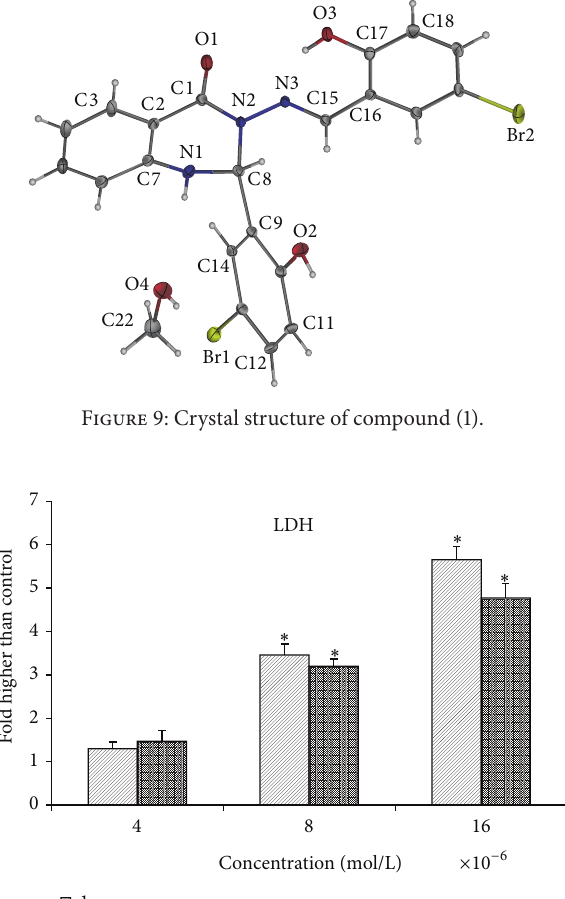
Table 1: X-ray crystallographic data table for compound